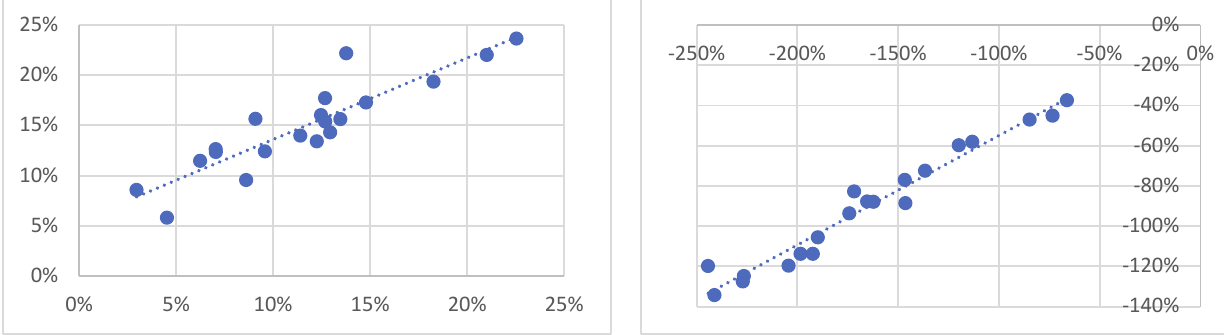
Fig. 4. Correlation between CTE and Mean of PM for